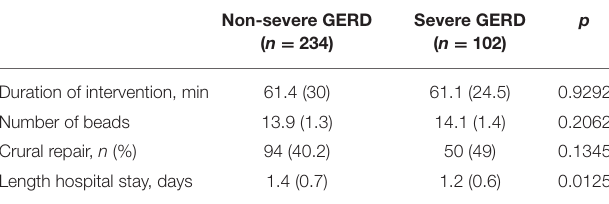
TABLE 4 | Intraoperative and clinical course of patients with severe or non-severe